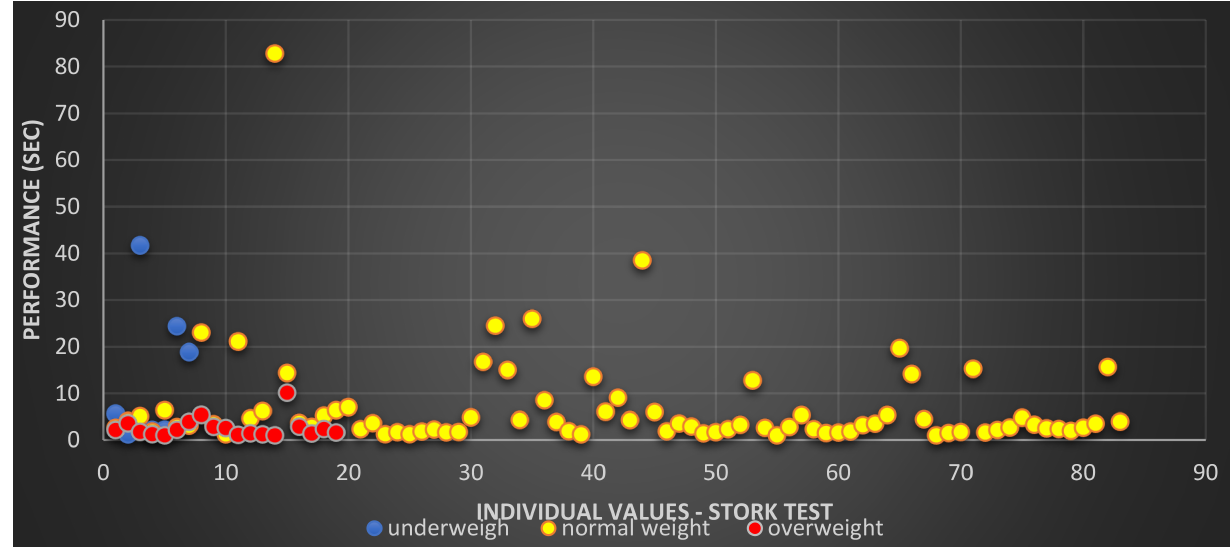
Fig. 1. Individual performance dynamics at the level of the 3 BMI groups for the Stork test.